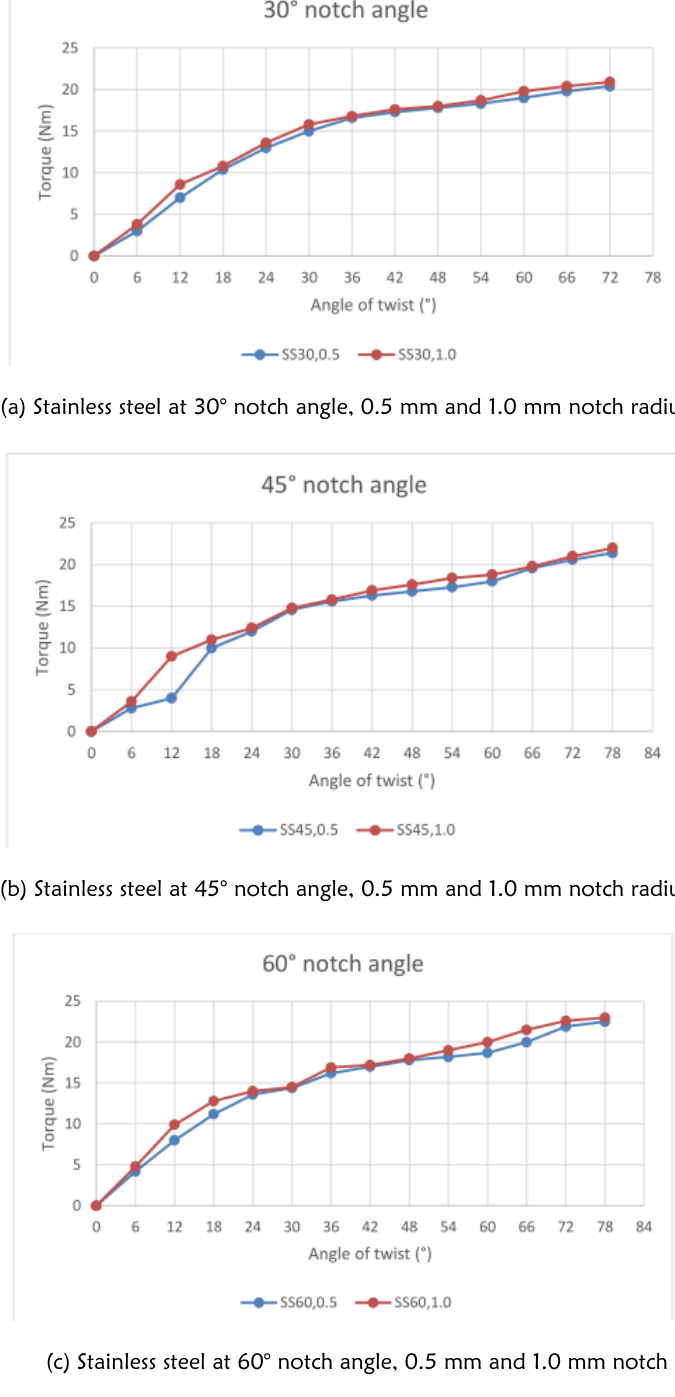
Figure 6: Effect of notch parameters on AISI 302 steel (Stainless